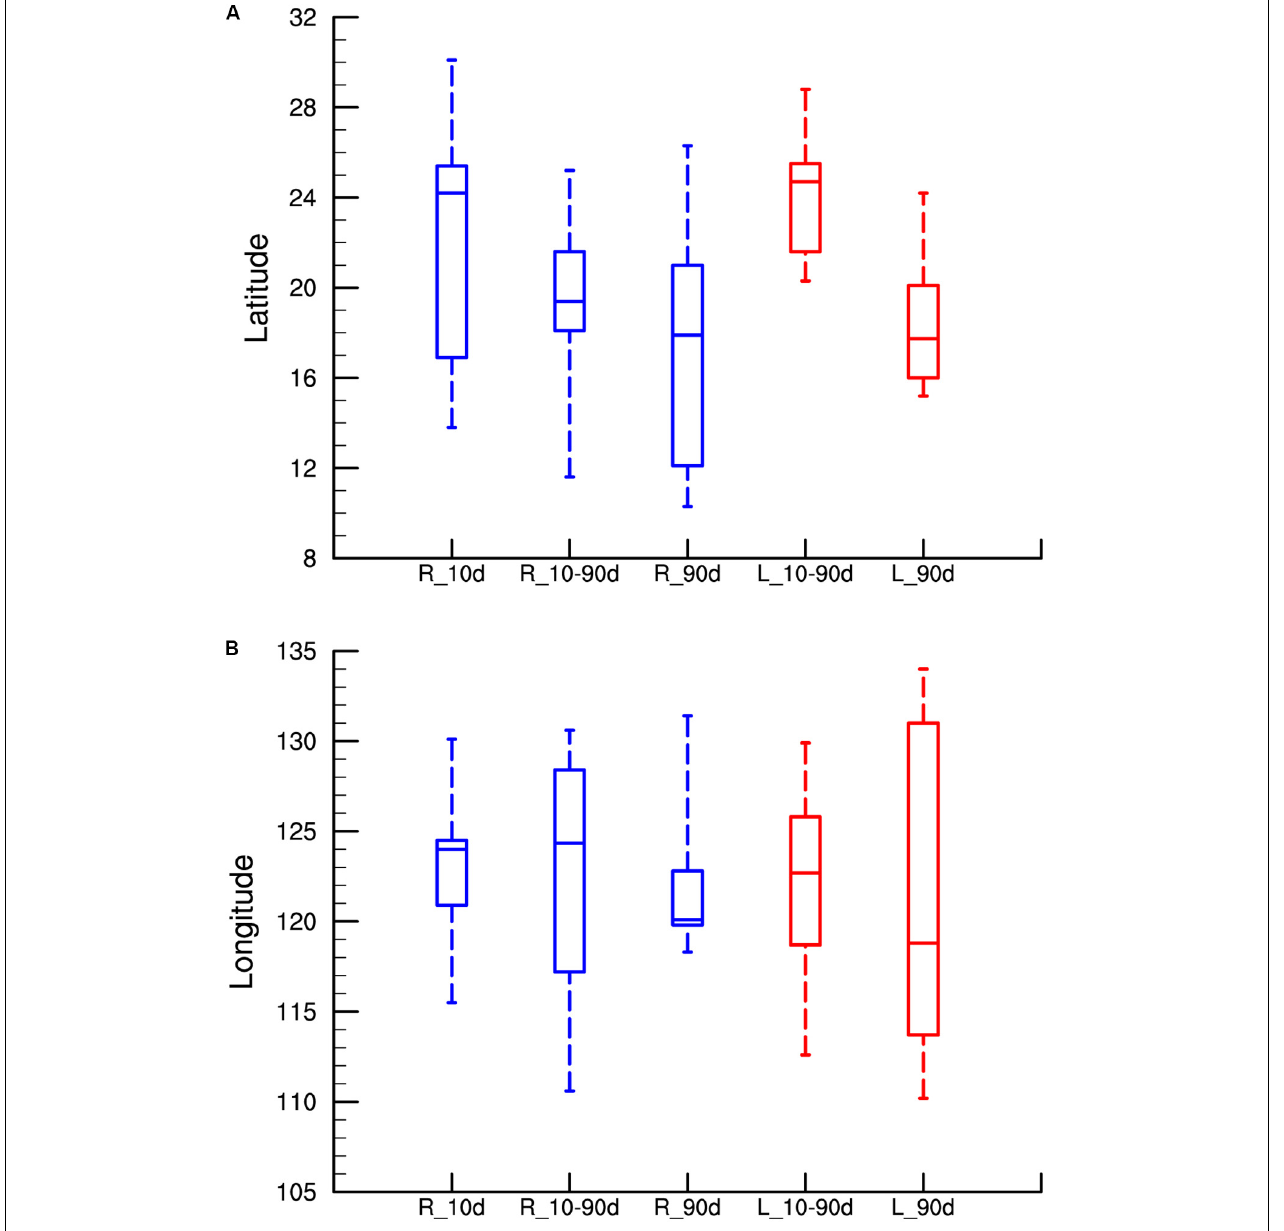
FIGURE 3 | Box-and-whisker plots of the mean (A) latitude and (B) longitude of the five-category sudden TC cases. The vertical bar displays the interquartile range of 25–75% of the all cases. The middle horizontal line denotes the